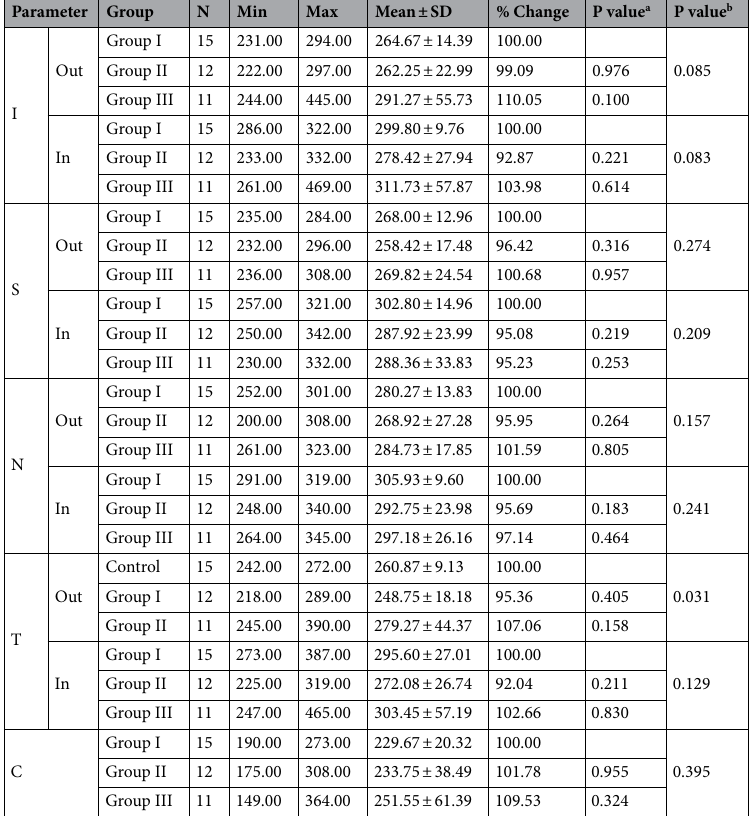
Table 2. Outer and inner macular thickness (µm) in four quadrants of right eye (OD) of controlled diabetic patients with and without retinopathy, compared to healthy control subjects. Comparisons done using one- way ANOVA test between all groups with multiple comparisons (Dunnett test) to compare each group with the control group in all parameters. a P value between each group and the control group. b P value between all